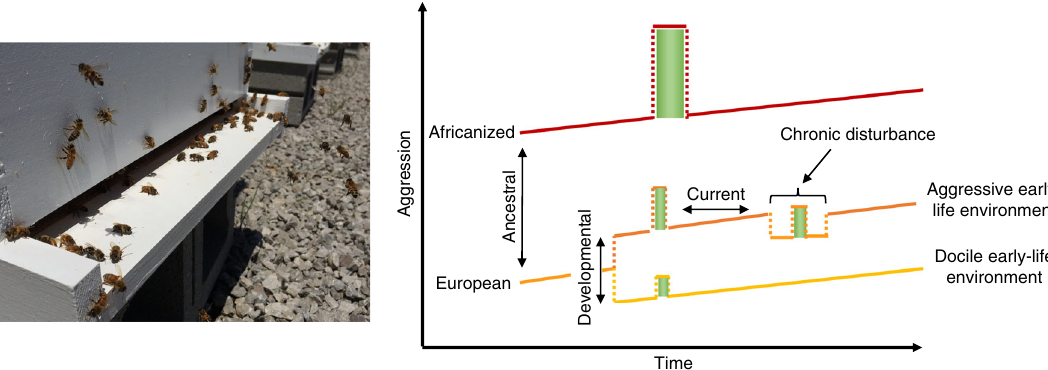
Fig. 4 Honey bee aggression shows a high degree of environmental sensitivity throughout life, as well as heritable variation as a function of genotype. Right: Solid lines indicate the continuous increase in aggressive tendency that occurs as bees age. Dotted lines indicate environmentally induced changes in aggression, which have variable timescales of effect. Green bars indicate short-term changes in aggression as a function of acute exposure to a